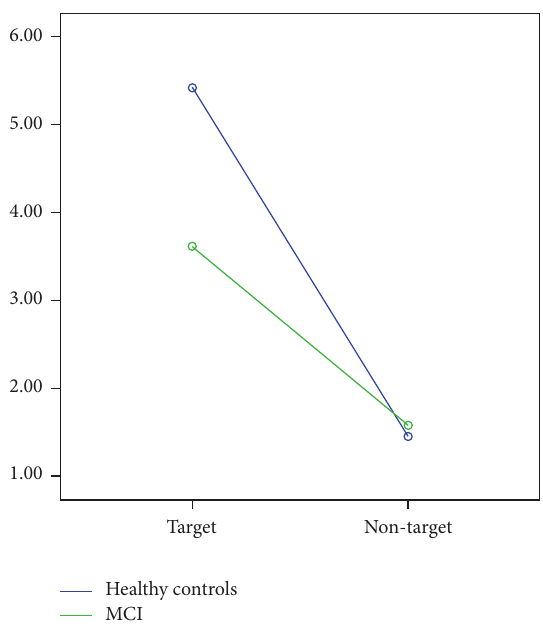
Figure 4: Frontal delta (0.5–2.2 Hz) target and nontarget responses of healthy controls and MCI